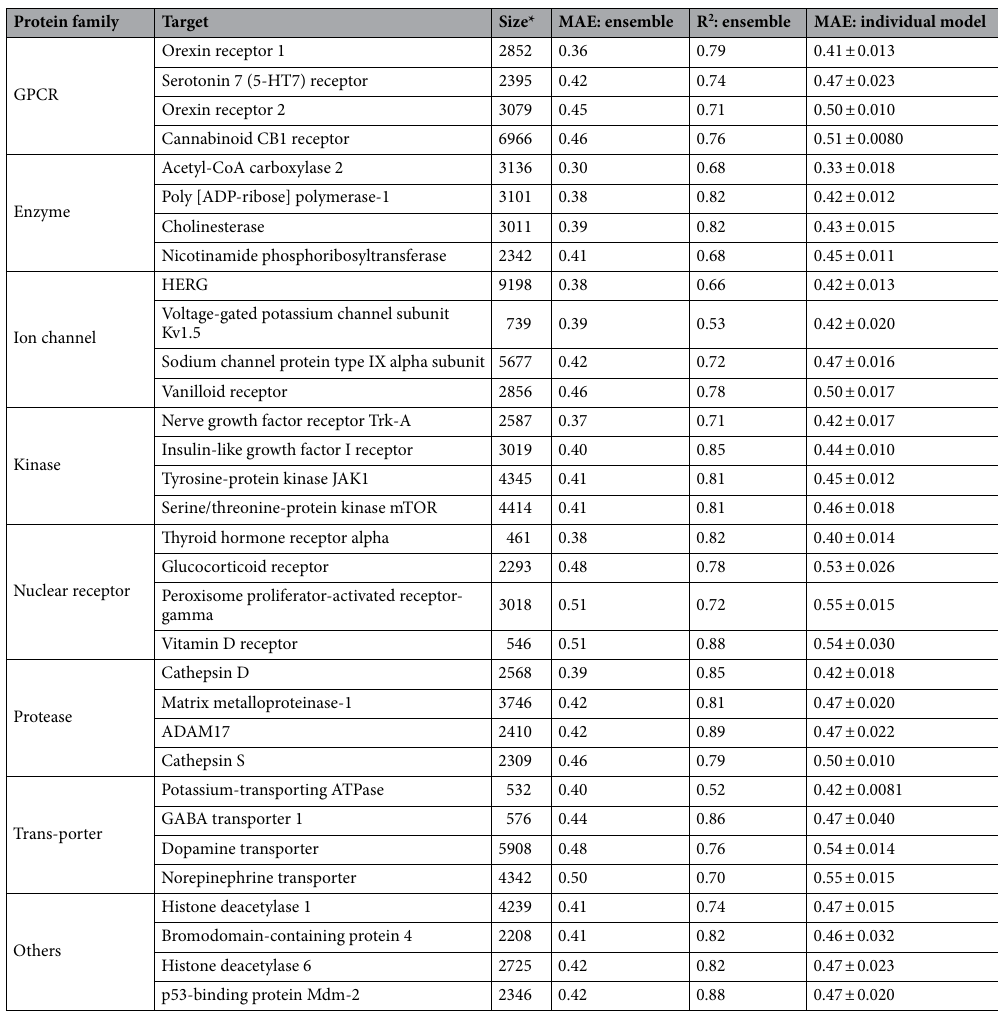
Table 2. The top four ensemble models for each protein family based on the MAE values (ensemble). *Size: The number of compounds in the dataset.